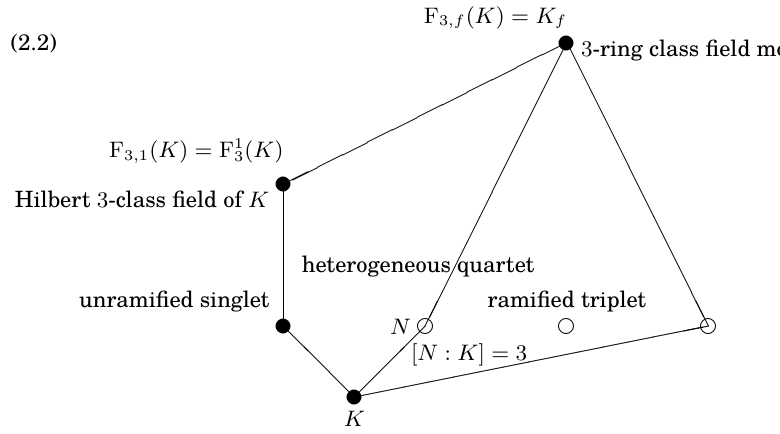
Figure 9: Heterogeneous quartet modulo f = 19 over K